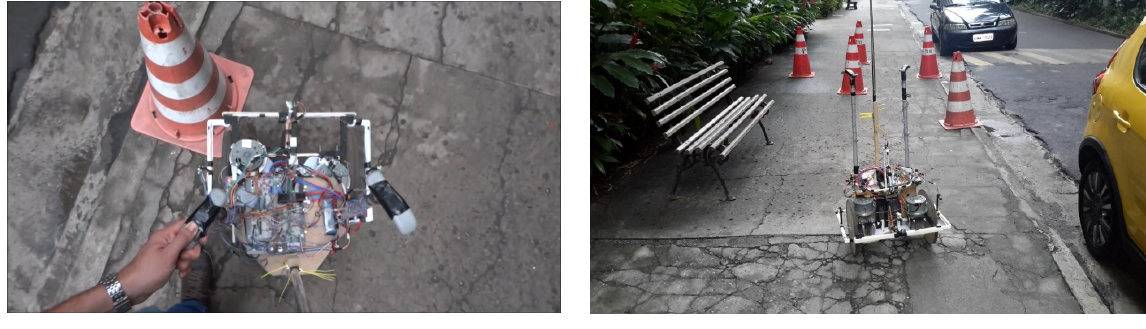
Figure 24. Route 3 observation points.